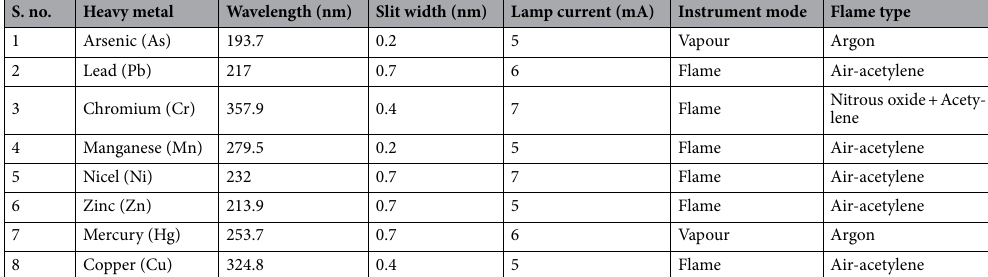
Table 2. FAAS operating conditions for the determination of heavy metals in sand samples.